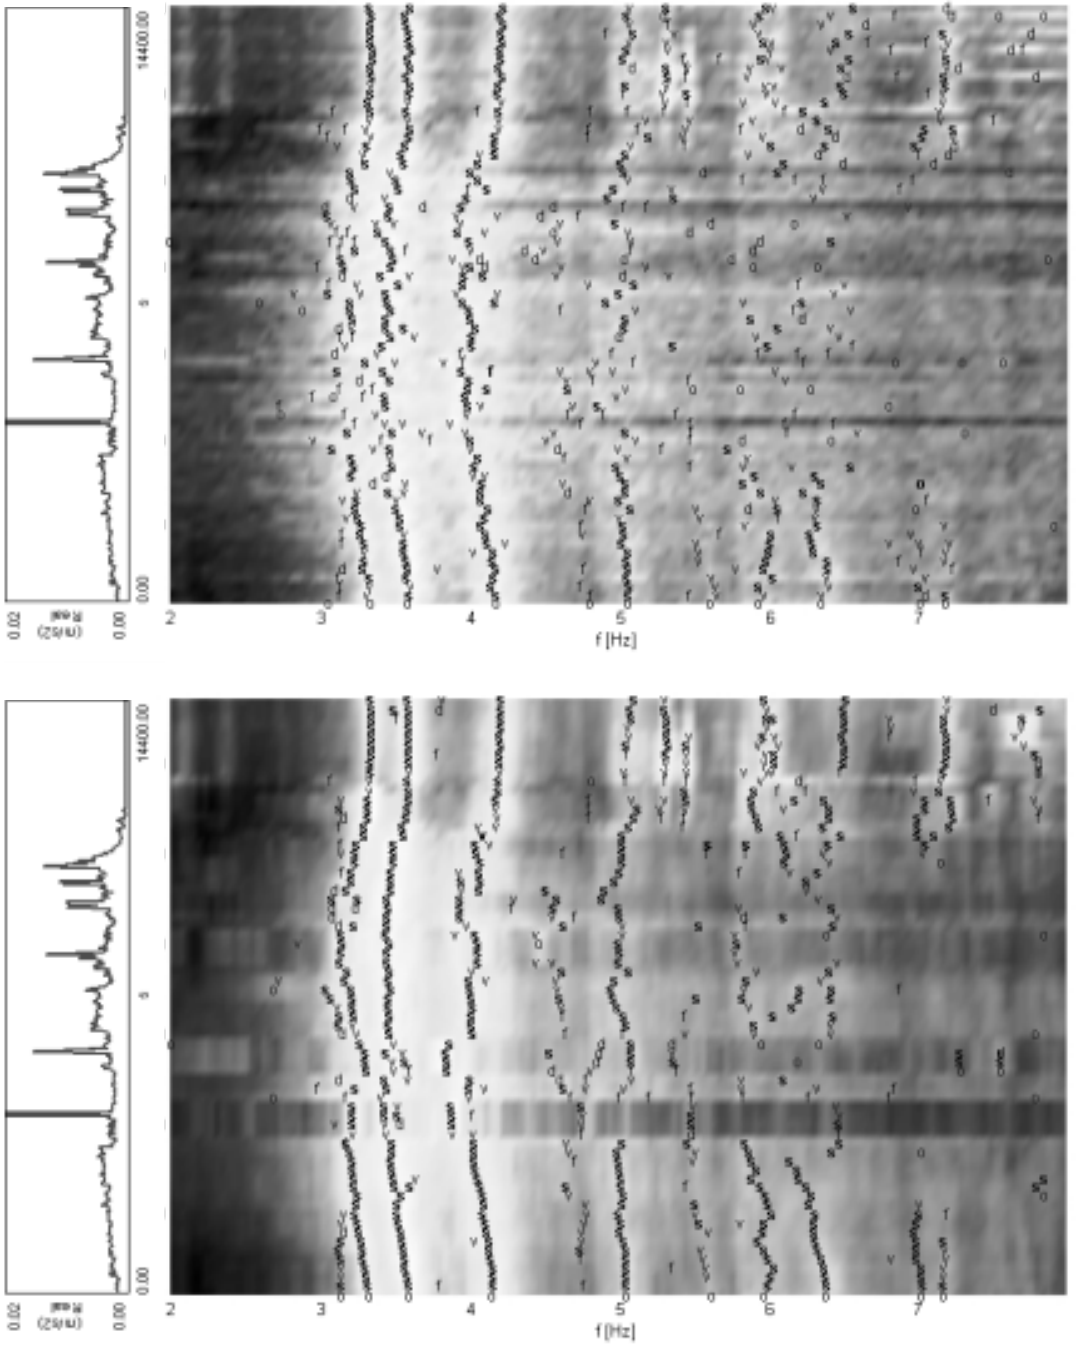
Fig. 15. Unusual stabilisation diagrams representing automatic modal analysis results: the y-axis is not the model order, but represents the time. Automatic PolyMAX analyses were performed on data segments of 204.8 s and no overlap (Top) and 819.2 s with 75% overlap (Bottom). The background image is the normalised 1 st singular value (CMIF) of the spectrum matrix computed for each segment. The curves on the Left represent the sliding RMS values (Fig.